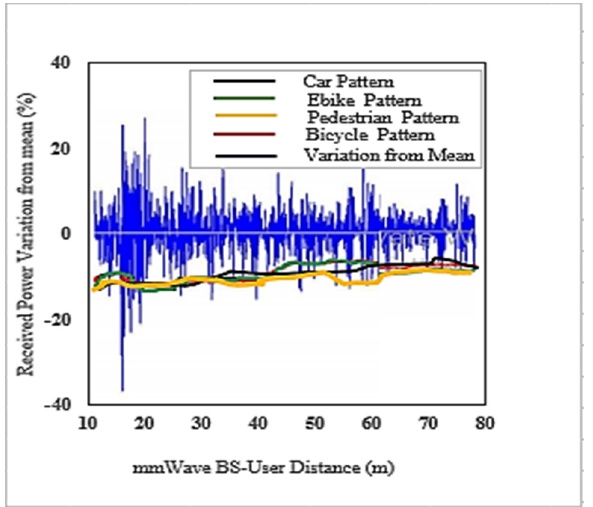
Figure 9. The actual average received power pattern variation at the UE as a percentage about the mean value after 200 episodes in the proposed JMLS–DDPG HO scheme .